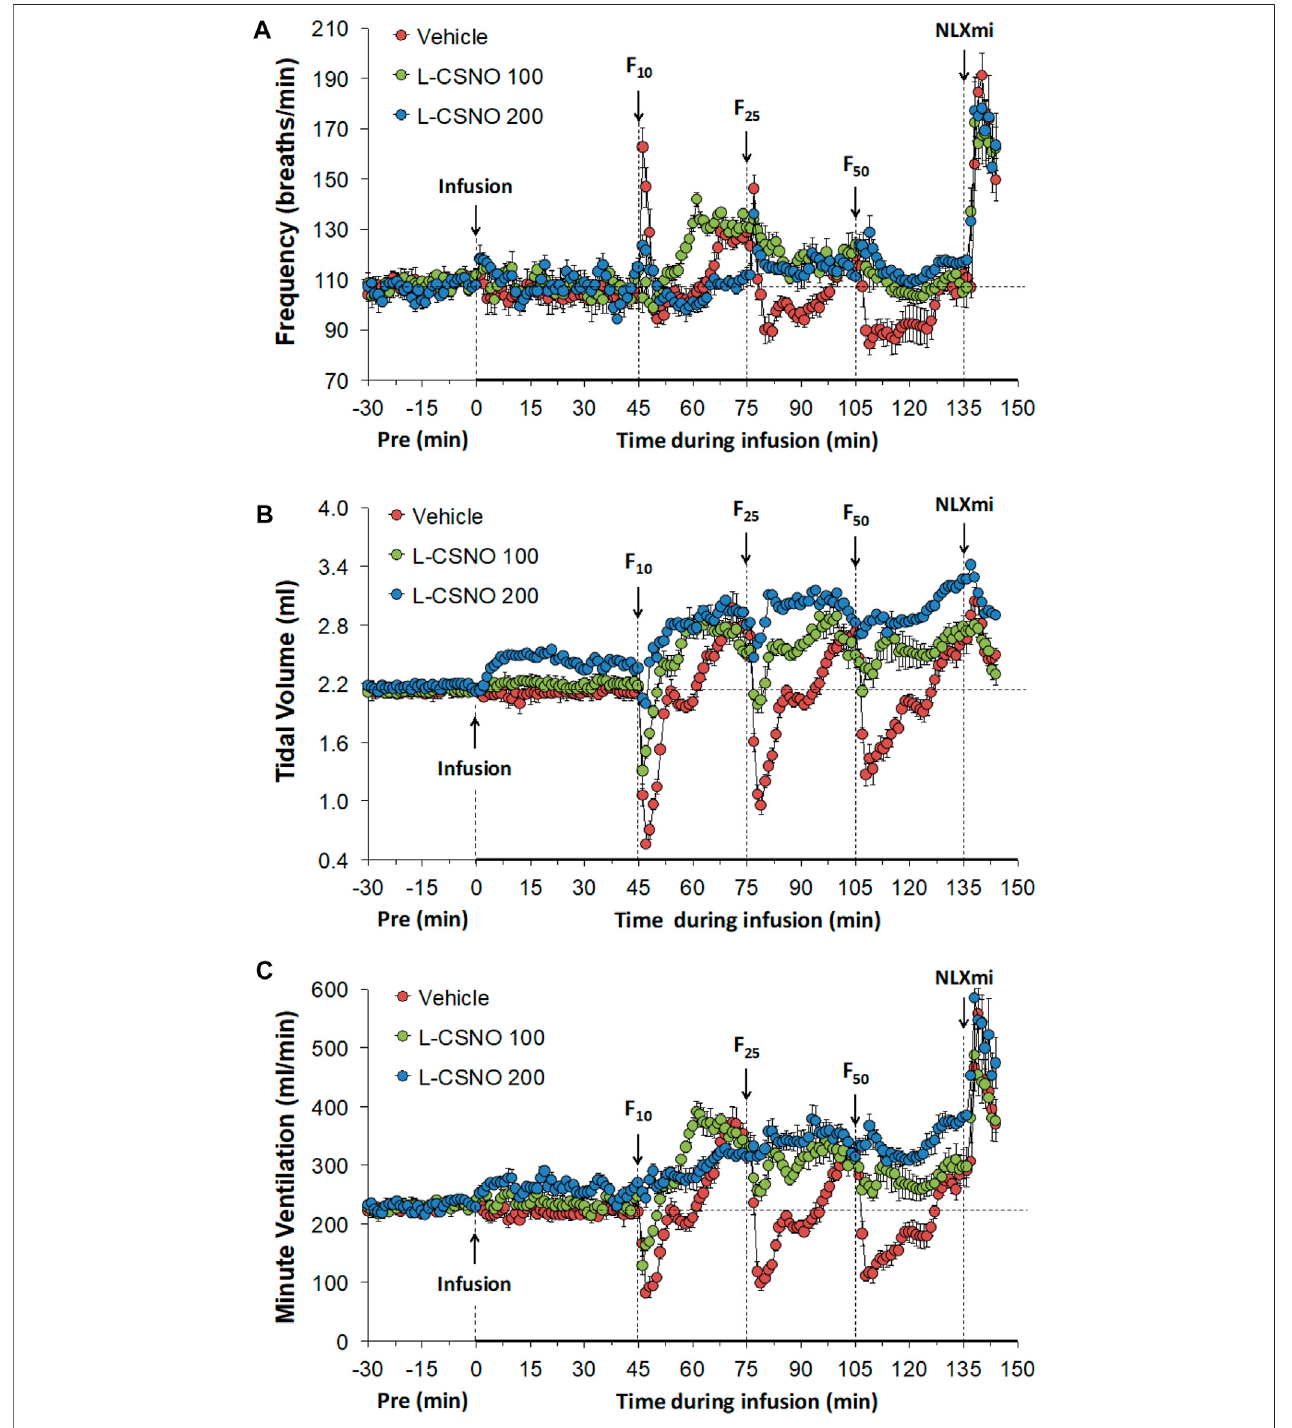
FIGURE 1 | Frequency of breathing (A) , tidal volume (B) and minute ventilation (C) values. The intravenous infusion of vehicle (20 μ l/min, IV), L-CSNO 100 (S-nitroso-L-cysteine, 100 nmol/kg/min, IV) or L-CSNO 200 (S-nitroso-L-cysteine, 200 nmol/kg/min, IV) began at time 0. Bolus injections of fentanyl at F10 (10 μ g/kg, IV), F25 (25 μ g/kg, IV), and F50 (50 μ g/kg, IV) were given at 45, 75, and 105 min, respectively. A bolus intravenous injection of naloxone methiodide (NLXmi, 1.5 mg/kg, IV) was given at time 135 min. Data are presented as mean ± SEM. There were 8 rats in each group.